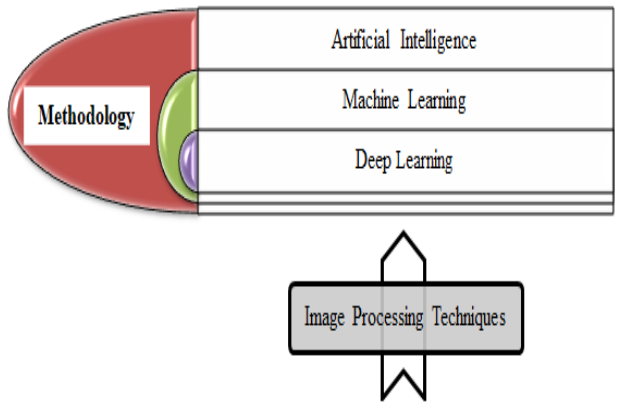
Figure 1. Methodology